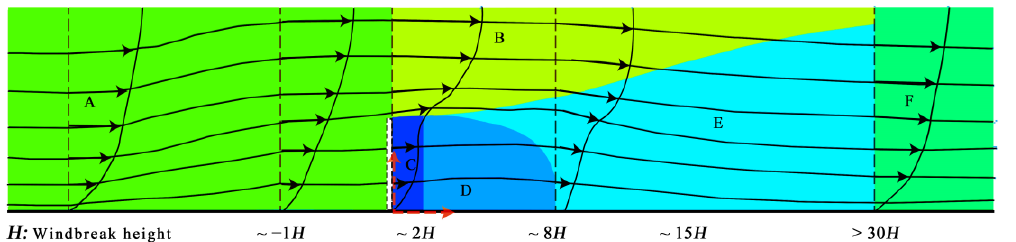
Figure 1. Schematic diagram of flow field around a windbreak. The areas with different colors in the figure indicate different regions mentioned in the text. The lines and arrows indicate streamlines around the windbreak. (Adapted from Judd et al.) [21].